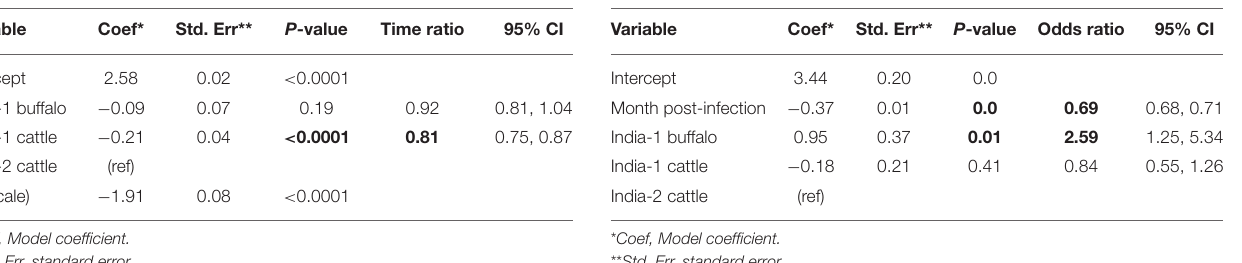
Significant values are indicated in bold.